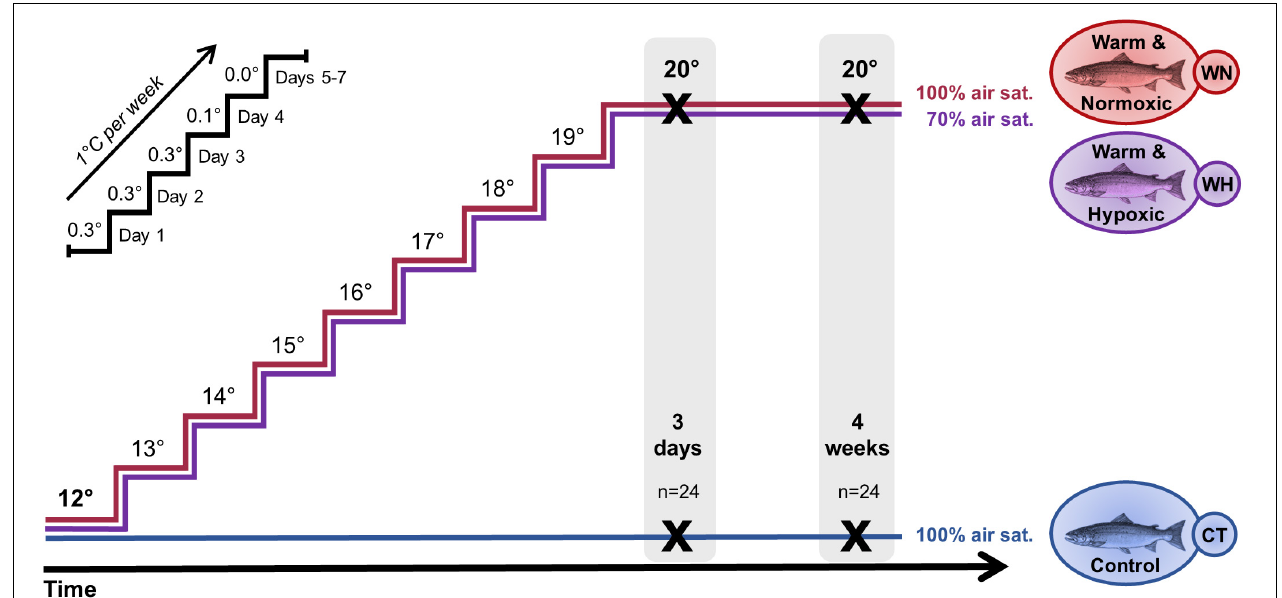
FIGURE 1 | Design of the temperature and hypoxia challenge with Atlantic salmon. Post-smolt salmon were either exposed to: (i) a temperature increase from 12 → 20 ◦ C and normoxia ( ∼ 100% air saturation) (Warm & Normoxic, WN); (ii) a temperature increase from 12 → 20 ◦ C and moderate hypoxia ( ∼ 70% air sat.) (Warm & Hypoxic, WH); or (iii) a constant water temperature of 12 ◦ C and normoxia ( ∼ 100% air sat.) (Control, CT). The temperature was increased by 1 ◦ C week - 1 , following the temperature regimen shown in the upper left portion of the figure. Liver samples were collected 3 days and 4 weeks after the temperature reached 20 ◦ C ( n = 8 per treatment/time point, N = 48 total) and used to measure gene expression (qPCR, Fluidigm Biomark TM ) and to examine CpG methylation (Multiplex Bisulfite Sequencing, MBS) in a ∼ 500 bp region around the transcription start